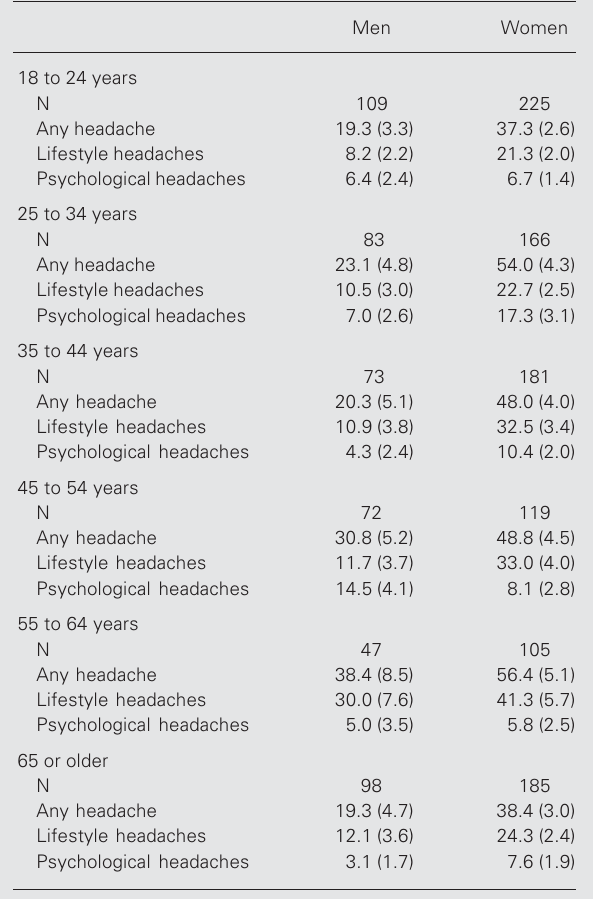
Table 1. Lifetime prevalence rates for “a lot of problems with” headache of any type, headaches attributed to lifestyle and/or physical conditions, and headaches attributed to psychological conditions, by gender and age